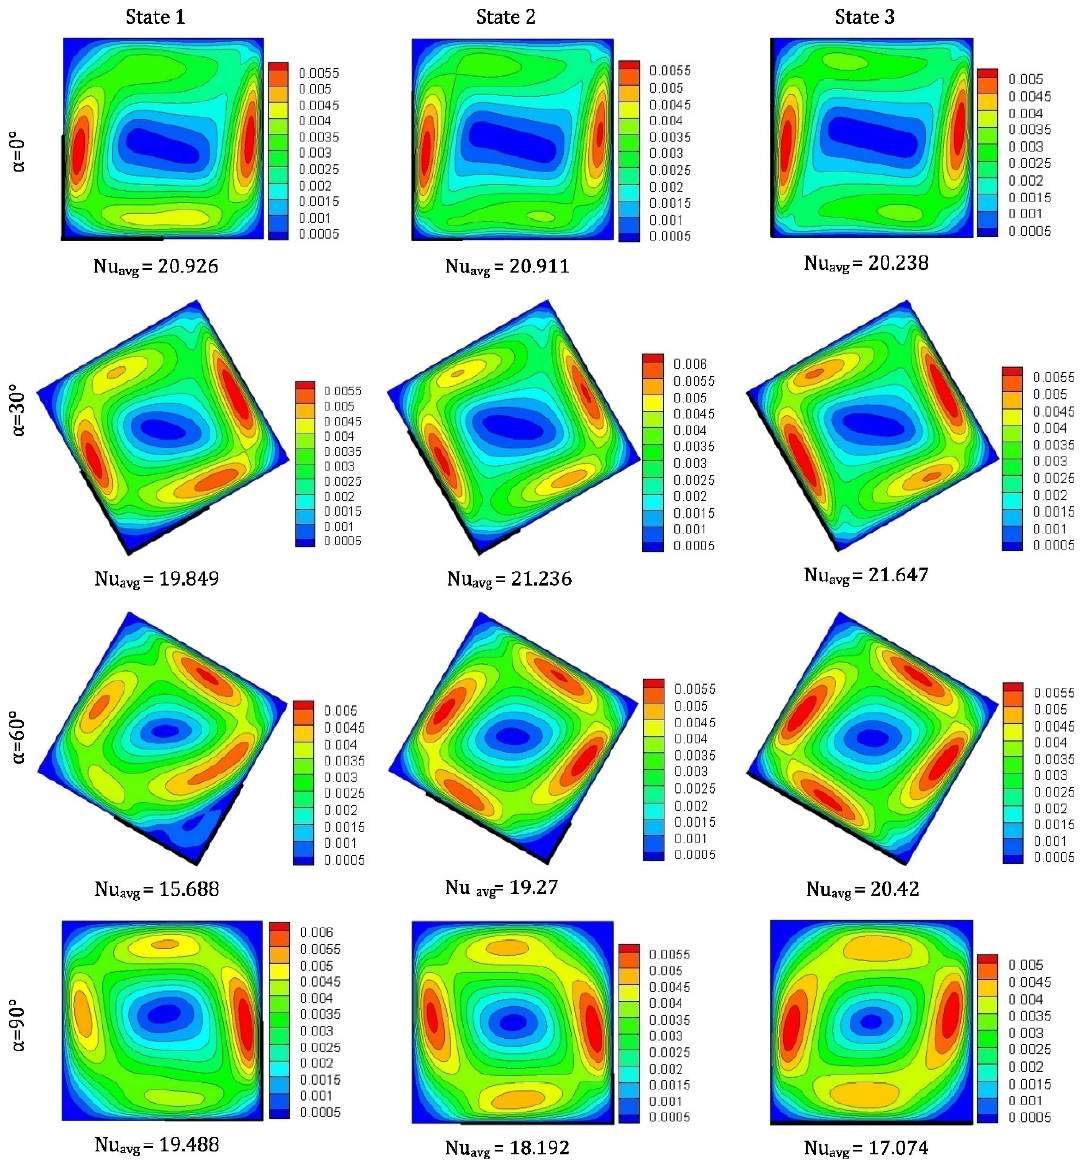
Figure 8. Effect of inclination angle on heat transfer in the square cavity [104].